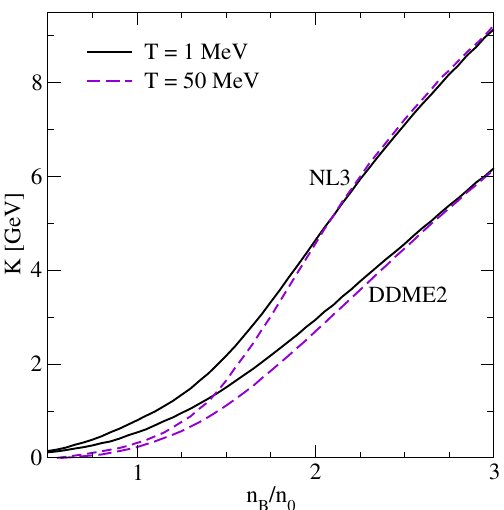
Figure 7. The isothermal incompressibility of nuclear matter as a function of density for several temperatures for models DDME2 and